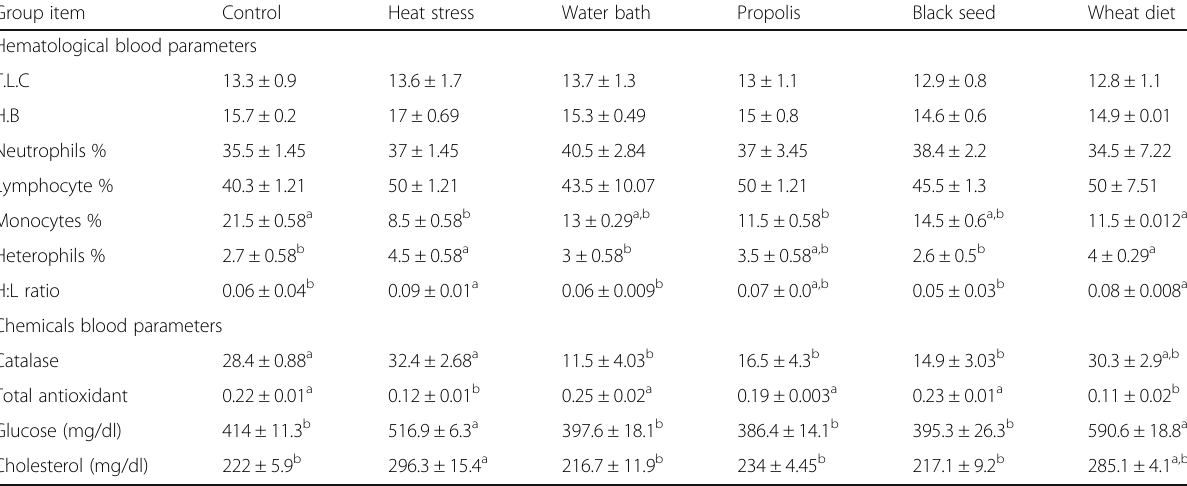
Table 5 Managerial and nutritional effect on blood parameters of heat-stressed pigeon Group